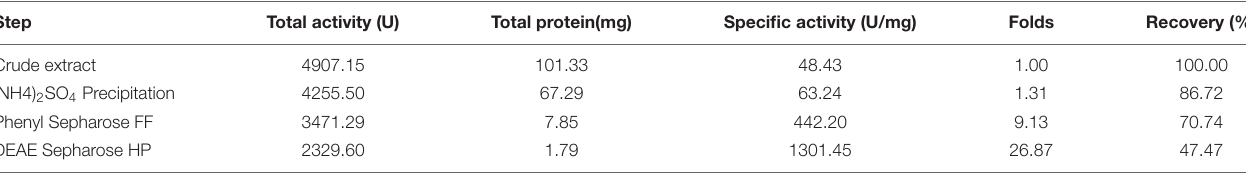
TABLE 1 | Purification of native alginate lyase VxAly7B from V. xiamenensis